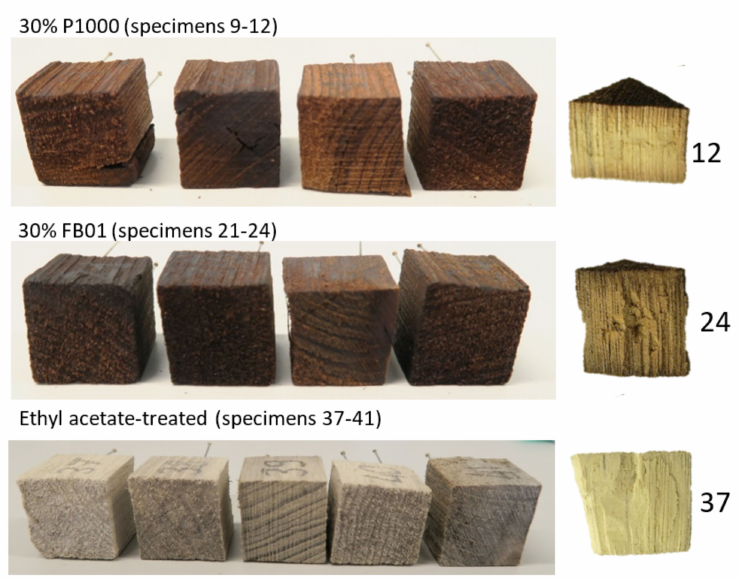
Figure 4. Specimens treatment with 30% lignins P1000, FB01 ( w / v ) and the control (ethyl acetate- immersed) after air-drying. Specimens 12, 24 and 37 are also shown after they were cut in half for